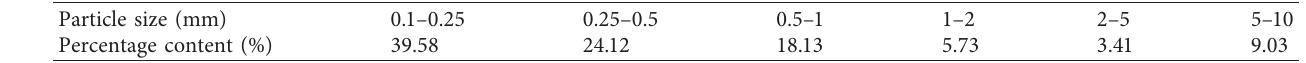
Table 2: Particle size composition of reclaimed soil for numerical calculation model.